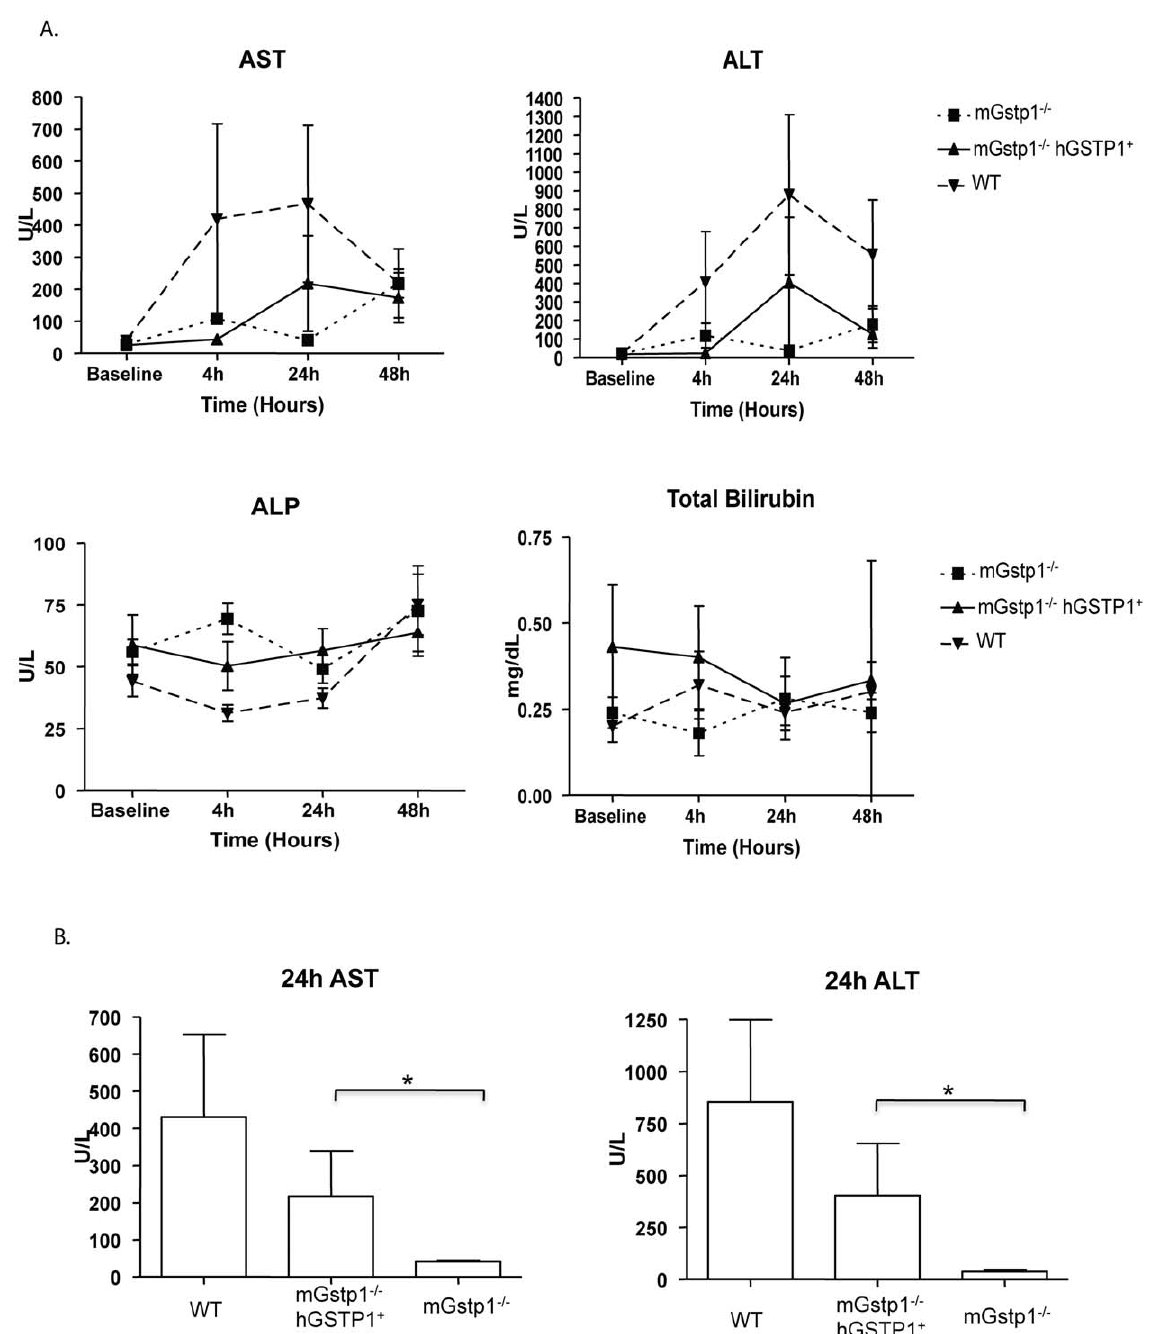
Figure 6. Acetaminophen-induced hepatic injury in male wildtype, mGstp1/2 2 / 2 , and hGSTP + mGstp1/2 2 / 2 mice. Baseline serum measurements were taken prior to administration of the drug. Mice were fasted for 12 or 24 hours and then administered vehicle or 300 mg/kg acetaminophen via gavage. (A) Serum AST, ALT, ALP and total bilirubin measurements taken in serum collected at 4, 24, and 48 hours. (B) Serum measurements of AST and ALT at 24 hours after acetaminophen administration. N=5 mice per group *=p , 0.05 by Students t-test. doi:10.1371/journal.pone.0025707.g006 5 9 -CTGTAGCGGCTGATGTTGAA -3 9 , and mGstp1/2 2 / 2 reverse 5 9 -ATGGCGATTACCGTTGATGT -3 9 . To assess patterns of p -class GST expression and DNA methylation, mice were euthanized in a CO 2 chamber according to Johns Hopkins Animal Care and Use Committee (ACUC) guidelines. After sacrifice, tissues were harvested and immediately placed in formalin or snap frozen in liquid nitrogen for further processing.